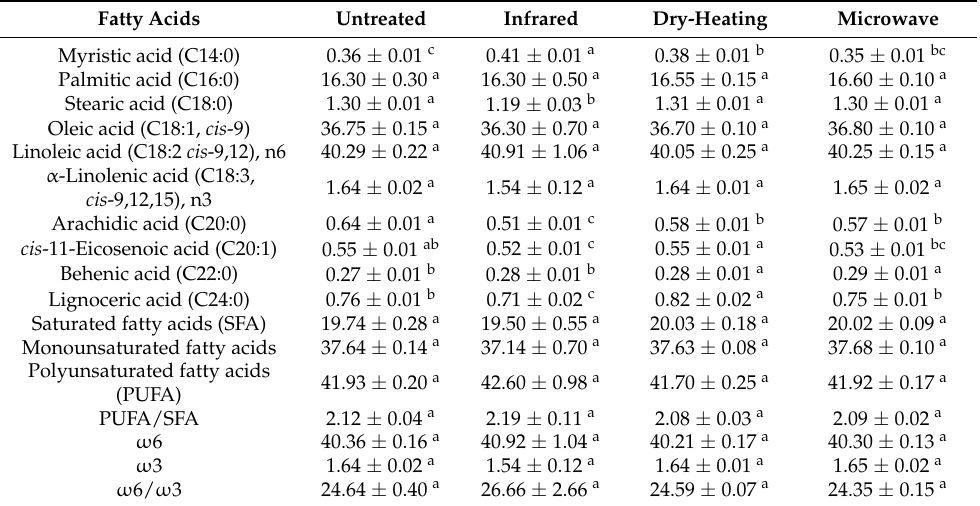
Table 2. Fatty acid profile of RB samples before and after heat treatments (% of the total fatty acids). Fatty